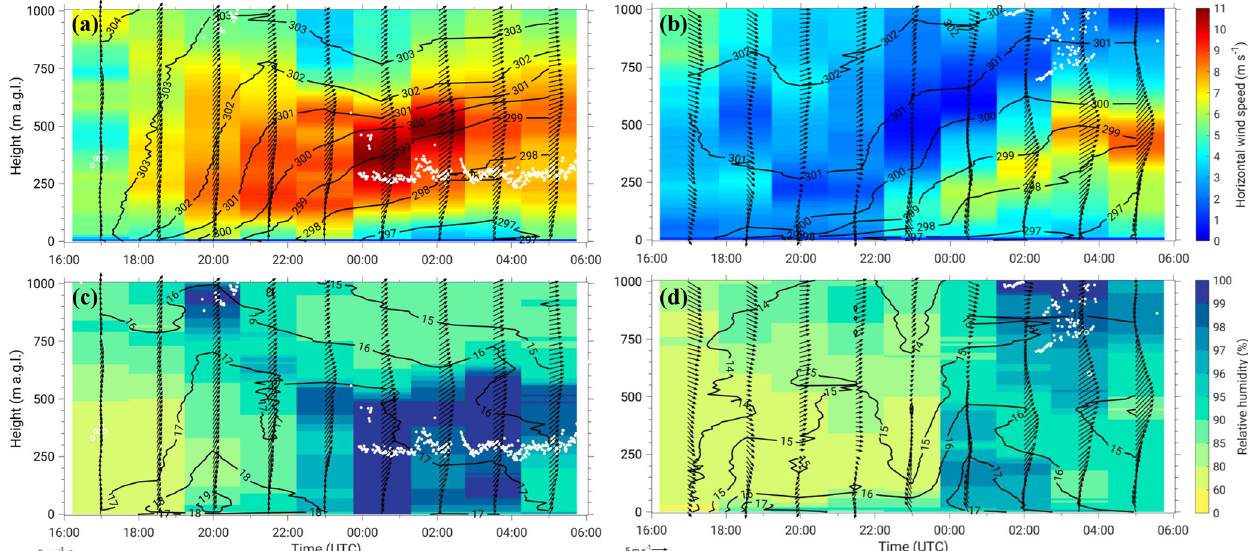
Figure 9. Temporal evolution of horizontal wind speed (color), horizontal wind vectors (arrows) and potential temperature (black isolines) measured at Savè supersite with normal and frequent radiosondes every 1.5h during stratus case (IOP 7; a ) and stratus-free case (IOP 10; b ). The white dots indicate the CBH. Temporal evolution of RH (color) and specific humidity (in gkg − 1 ; black isolines) for IOP 7 (c) and 10 (d) . The arrows in panels (c) and (d) show horizontal wind vectors. Please note that the scale of wind vectors corresponding to the same horizontal wind speed is not the same for IOP 7 and 10.